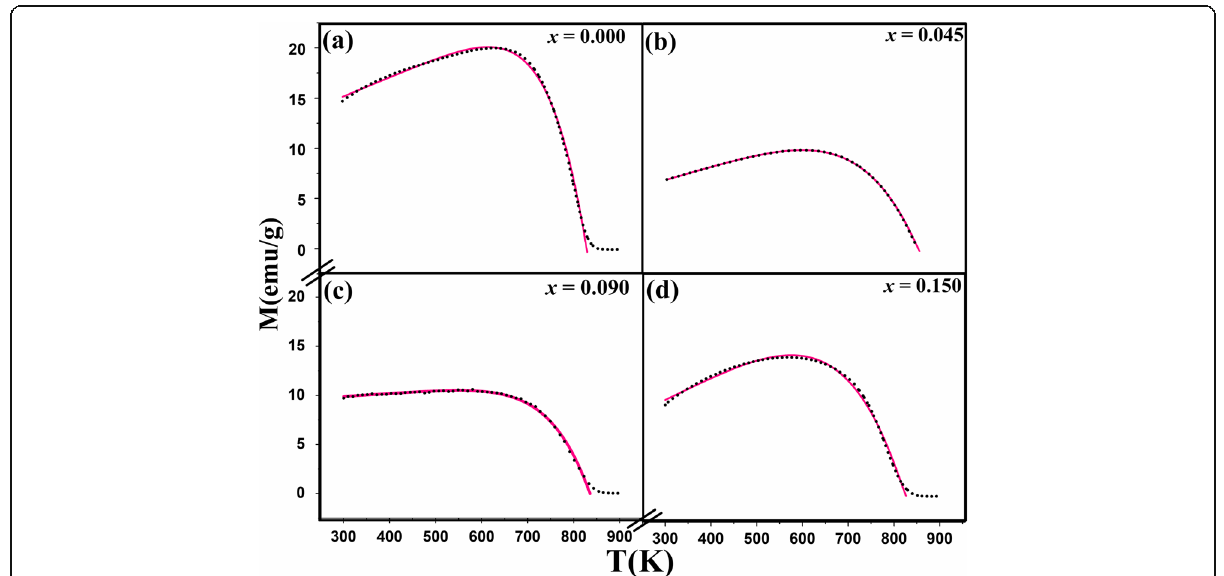
Fig. 13 Change of magnetization ( M ) with temperature during heating (the 3rd cycles) of the heated Sn x Fe 3-2/3 x O 4 nanoparticles with different amount of the indicated x (0.000, 0.045, 0.090, 0.150) ( H = 200 Oe) (black dotted, experimental; pink solid,